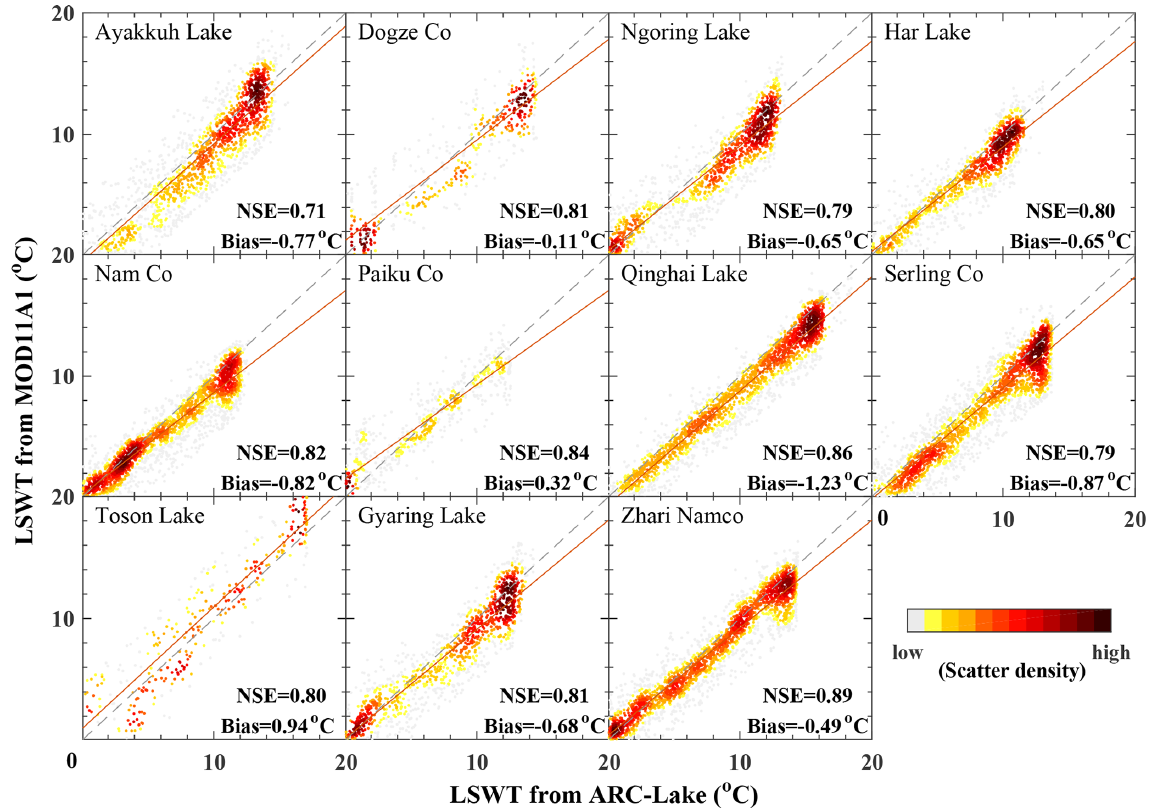
Figure 4. Comparison of LSWT from MOD11A1 and ARC-Lake datasets for the period with LSWT > 0 ◦ C. The dashed lines are the 1 : 1 lines and the solid lines are the linear regression